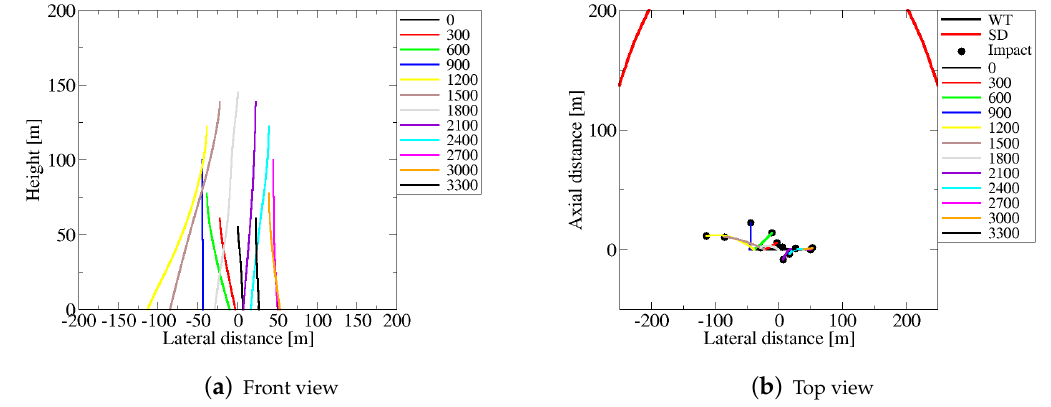
Figure 11. Trajectories from a standing still wind turbine. Computations based on